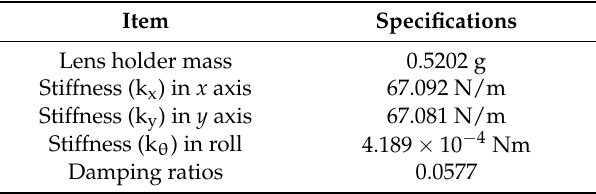
Table 2. Parameters of optical image